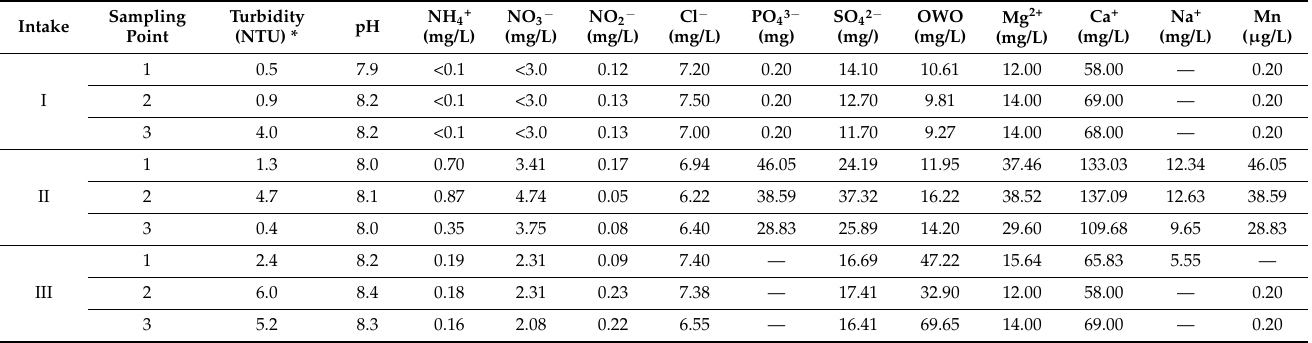
Table 1. Average values of selected physicochemical parameters of the Bludzia river from 2020–2021.